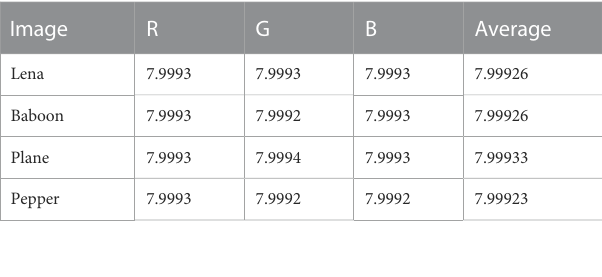
TABLE 2 Analysis of information entropy. TABLE 3 Information entropy